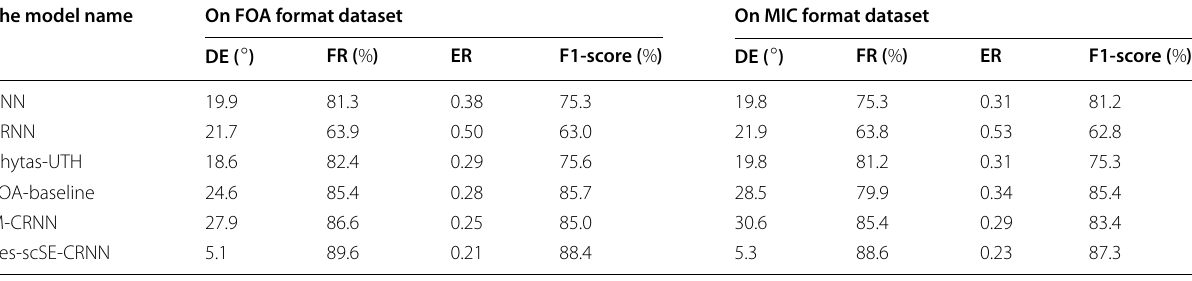
Table 6 Performance comparison of each model on FOA and MIC format dataset The model